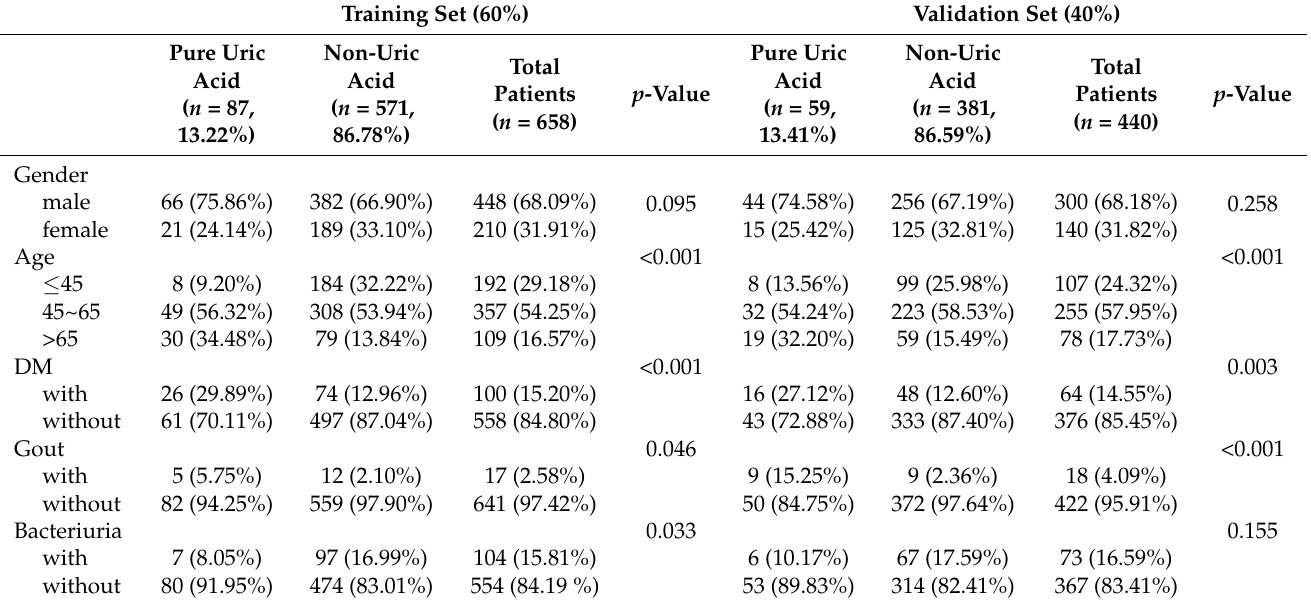
Table 1. Descriptive analysis of the Cohort A included in model training and validation sets.